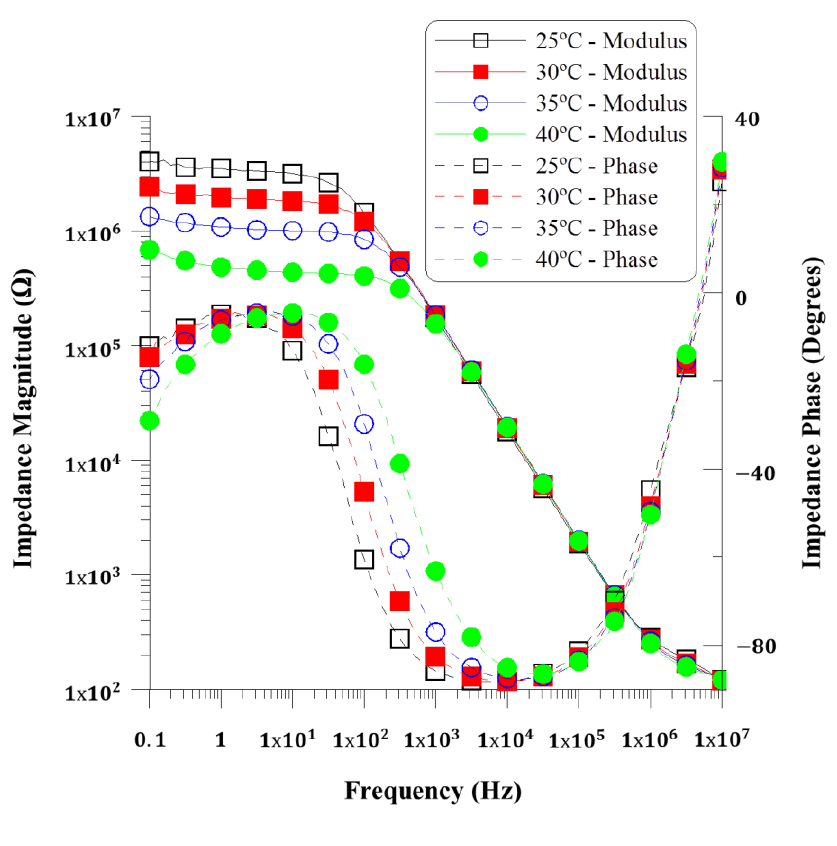
Figure 2. Experimental complex impedance as a function of frequency in the temperature range between 25 °C and 40